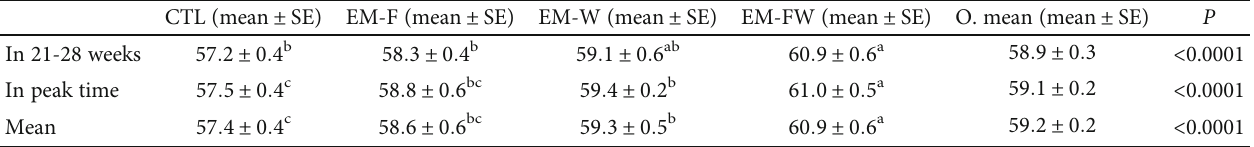
Table 5: Average egg weight of chickens treated with EM (e ff ective